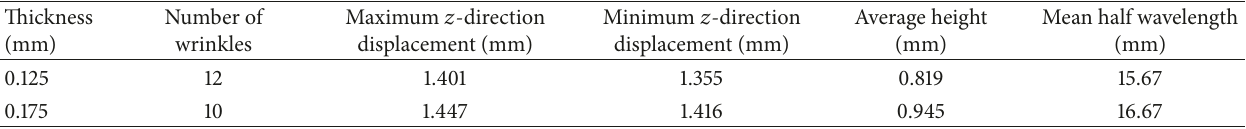
Table 9: Influence of membrane thickness.